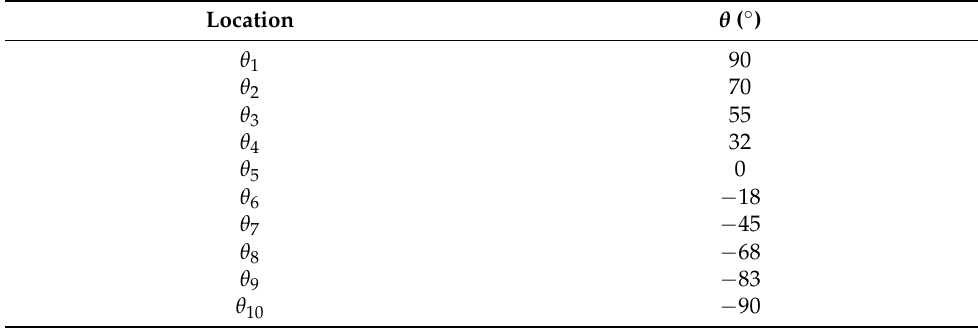
Table 2. θ 1 – θ 10 between the n-axis and x -axis.